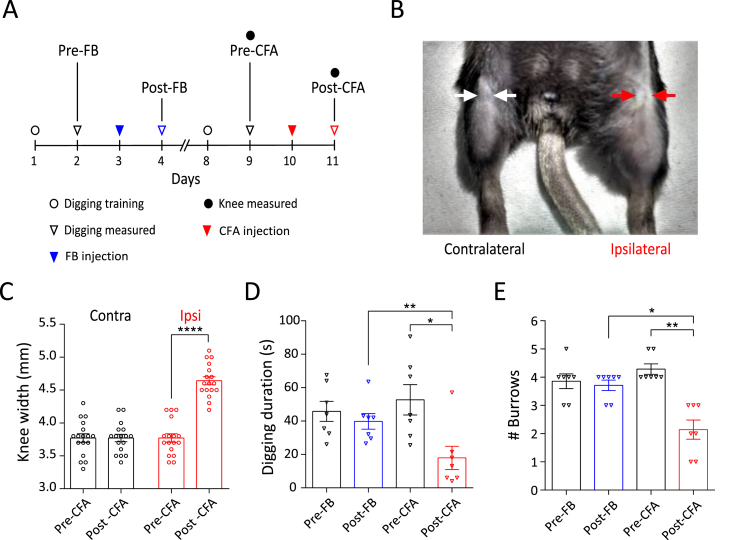
CFA model of acute knee inflammation in mice. A) Experimental timeline indicating when intra-articular injections, behavioral training and measurements were conducted. B) Representative picture of CFA injected (ipsilateral) and non-injected (contralateral) knee (shaved before injections). Arrows indicate where knee width was measured. C) Knee width on the day of CFA injection (pre) and 24-h after CFA injection (post) in the ipsilateral (red dots) and contralateral (black dots) knee (n = 17). **** indicates p < 0.0001, paired t-test. Plots of (D) time spent digging and (E) the number of visible burrows after a 3-min digging test (n = 7). * indicates p < 0.05, ** indicates p < 0.01, repeated measures ANOVA, Holm-Sidak multiple comparison test. Error bars indicate SEM. (For interpretation of the references to colour in this figure legend, the reader is referred to the Web version of this article.)